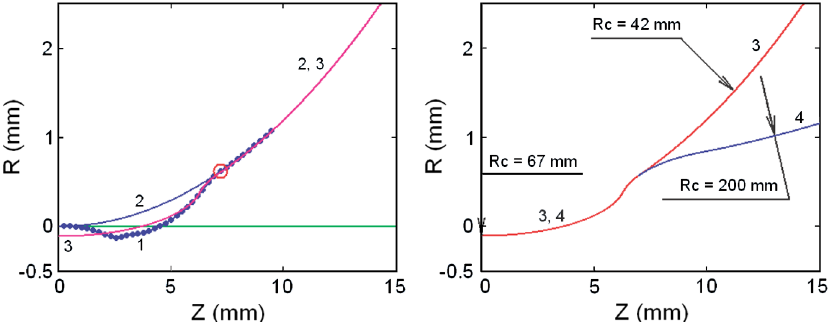
FIG. 14. Simplified approximation of the cavity seam profile for the TESLA cavity made by ACCEL and for the 200 MHz Nb-Cu cavity fabricated at CERN and welded by ACCEL. 1—Measured profile of the TESLA cavity; 2—ideal contour with radius of 42 mm; 3—approximation of the TESLA seam profile by two ellipses; 4—approximation of the 200 MHz cavity seam profile.